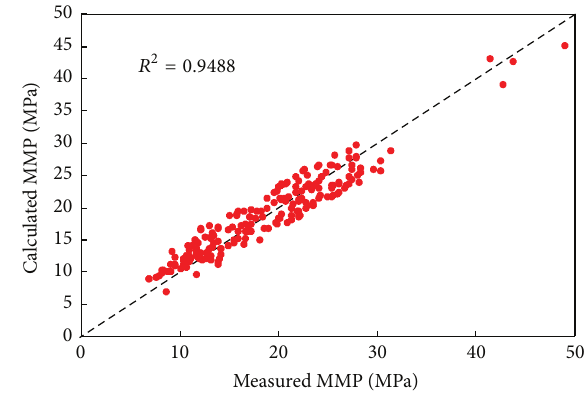
Figure 4: Resulted CO 2 -oil MMP from the new correlation versus the experimental